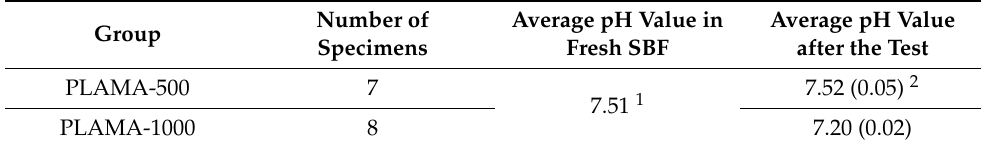
Table 7. Changes in the pH value of SBF after the SBF immersion test (84 days).